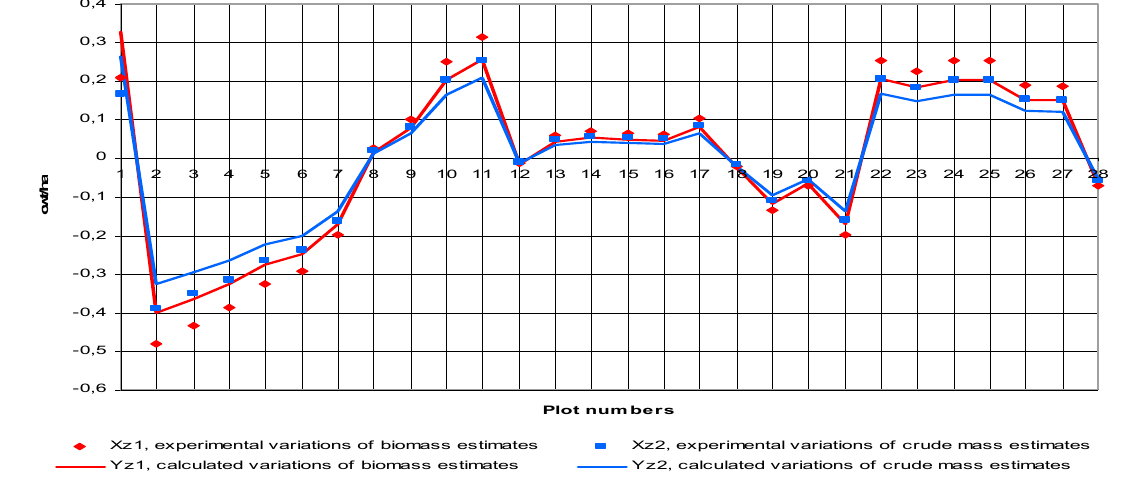
Figure 6. Adjustment of the spatial corrector of estimates of the biomass of spring wheat sowing in the time interval preceding heading.